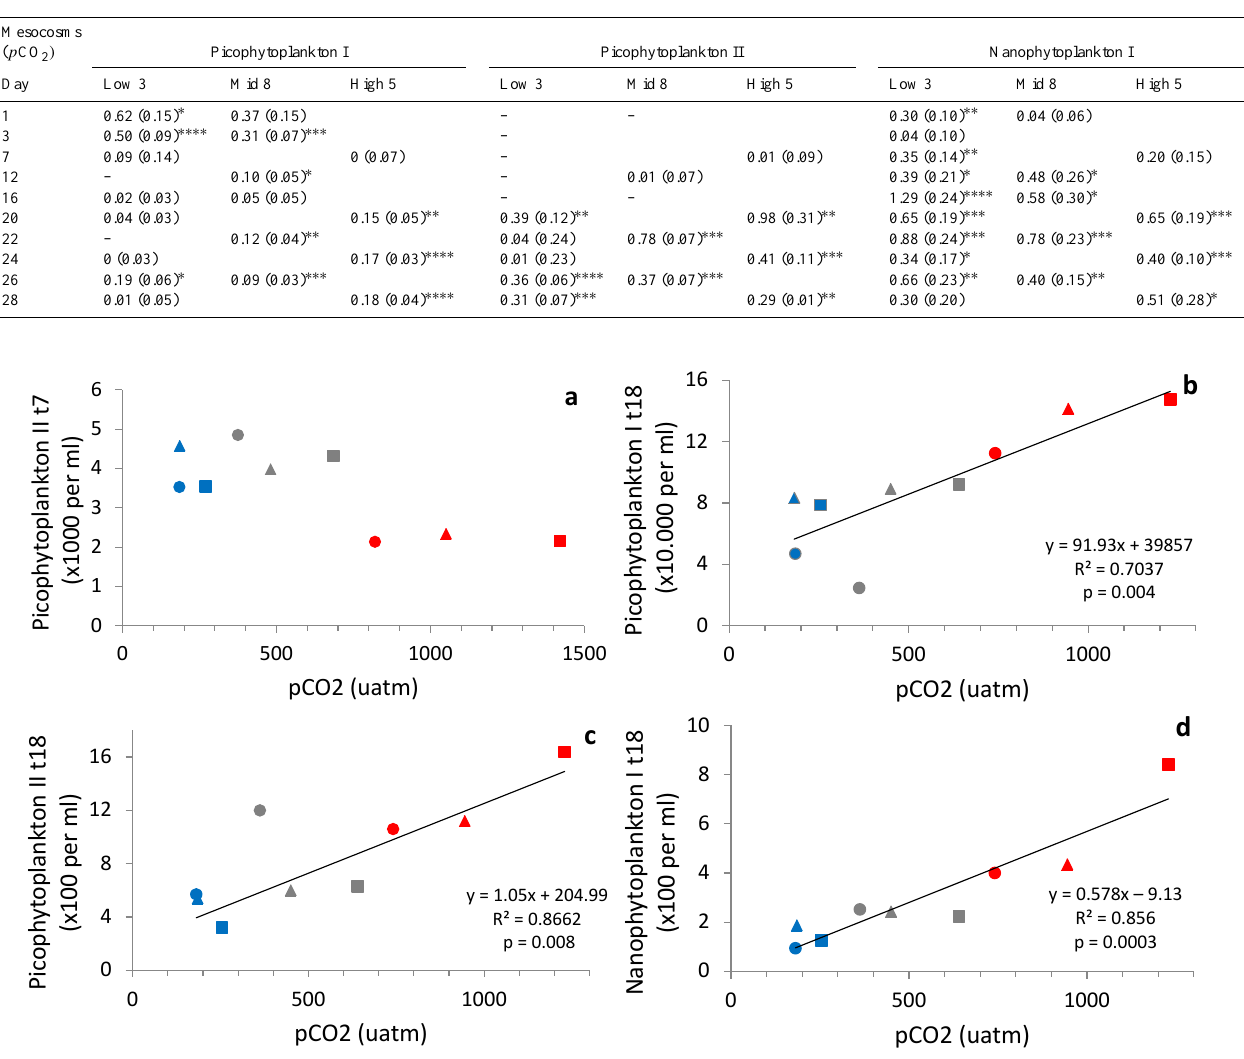
Fig. 3. Phytoplankton cell abundance versus actual p CO 2 for picophytoplankton II on t 7 (a) , picophytoplankton I on t 18 (b) , picophyto- plankton II on t 18 (c) , and nanophytoplankton I on t 18 (d) . For (b–d) the CO 2 concentrations plotted were the averages of t 8 to t 18. For color and symbol coding, see Fig. 1. Linear regression statistics provided in